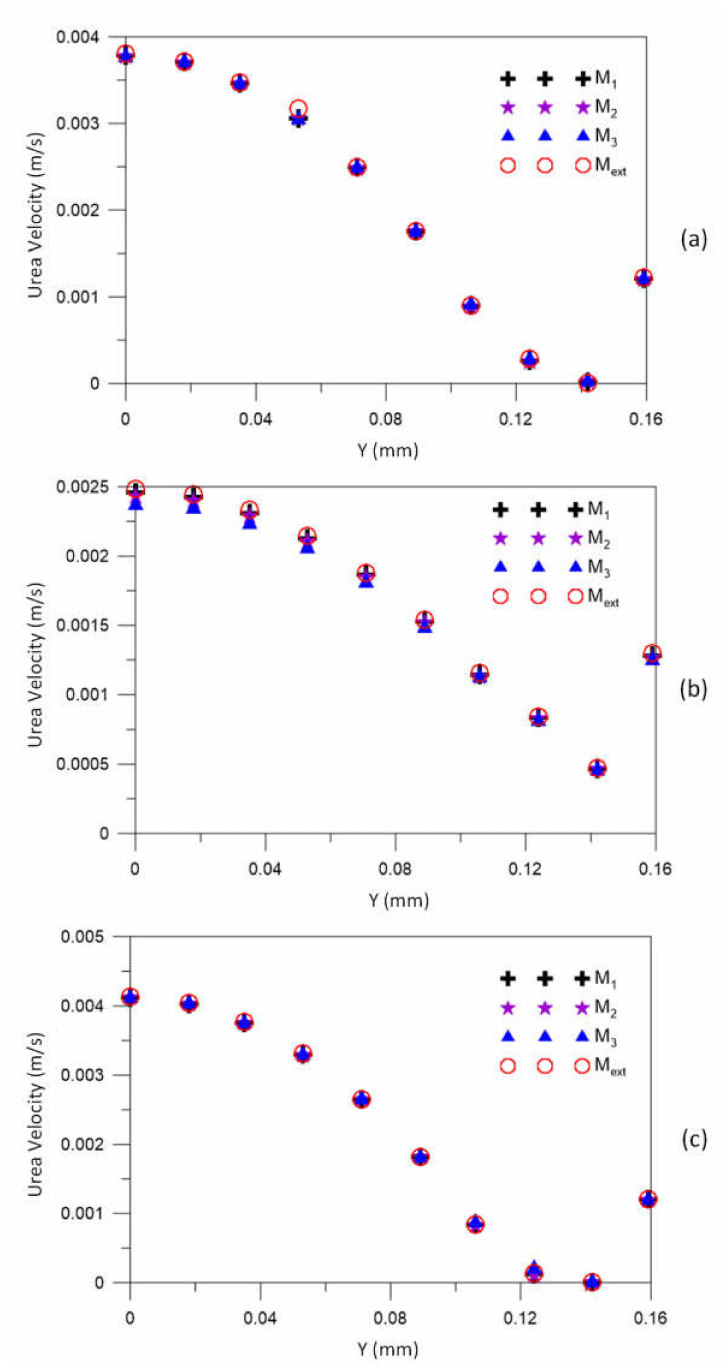
Figure 7. The urea velocity profile in ( a ) 20.0 mm, ( b ) 106.6 mm, and ( c ) 183.2 mm axial positions for different